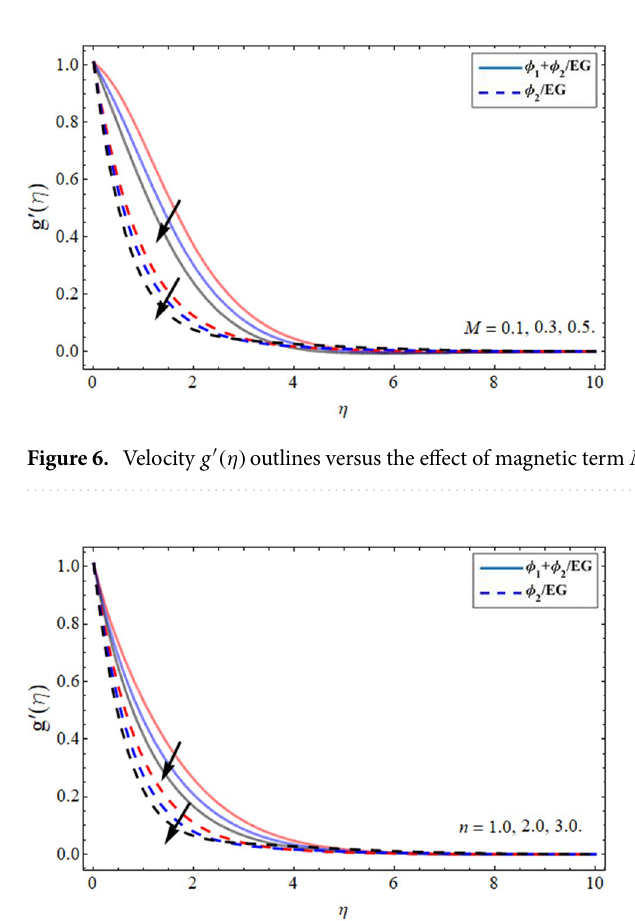
Figure 5. Velocity f ′ (η) outlines versus the effect of parameter n .